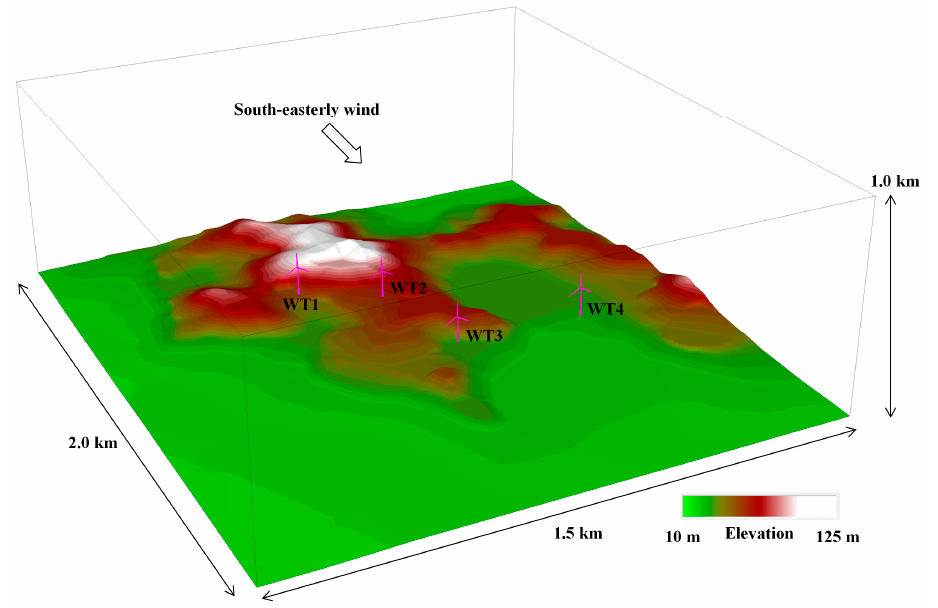
Figure 4. Computational domain, bird’s eye view, colors indicate the elevation.